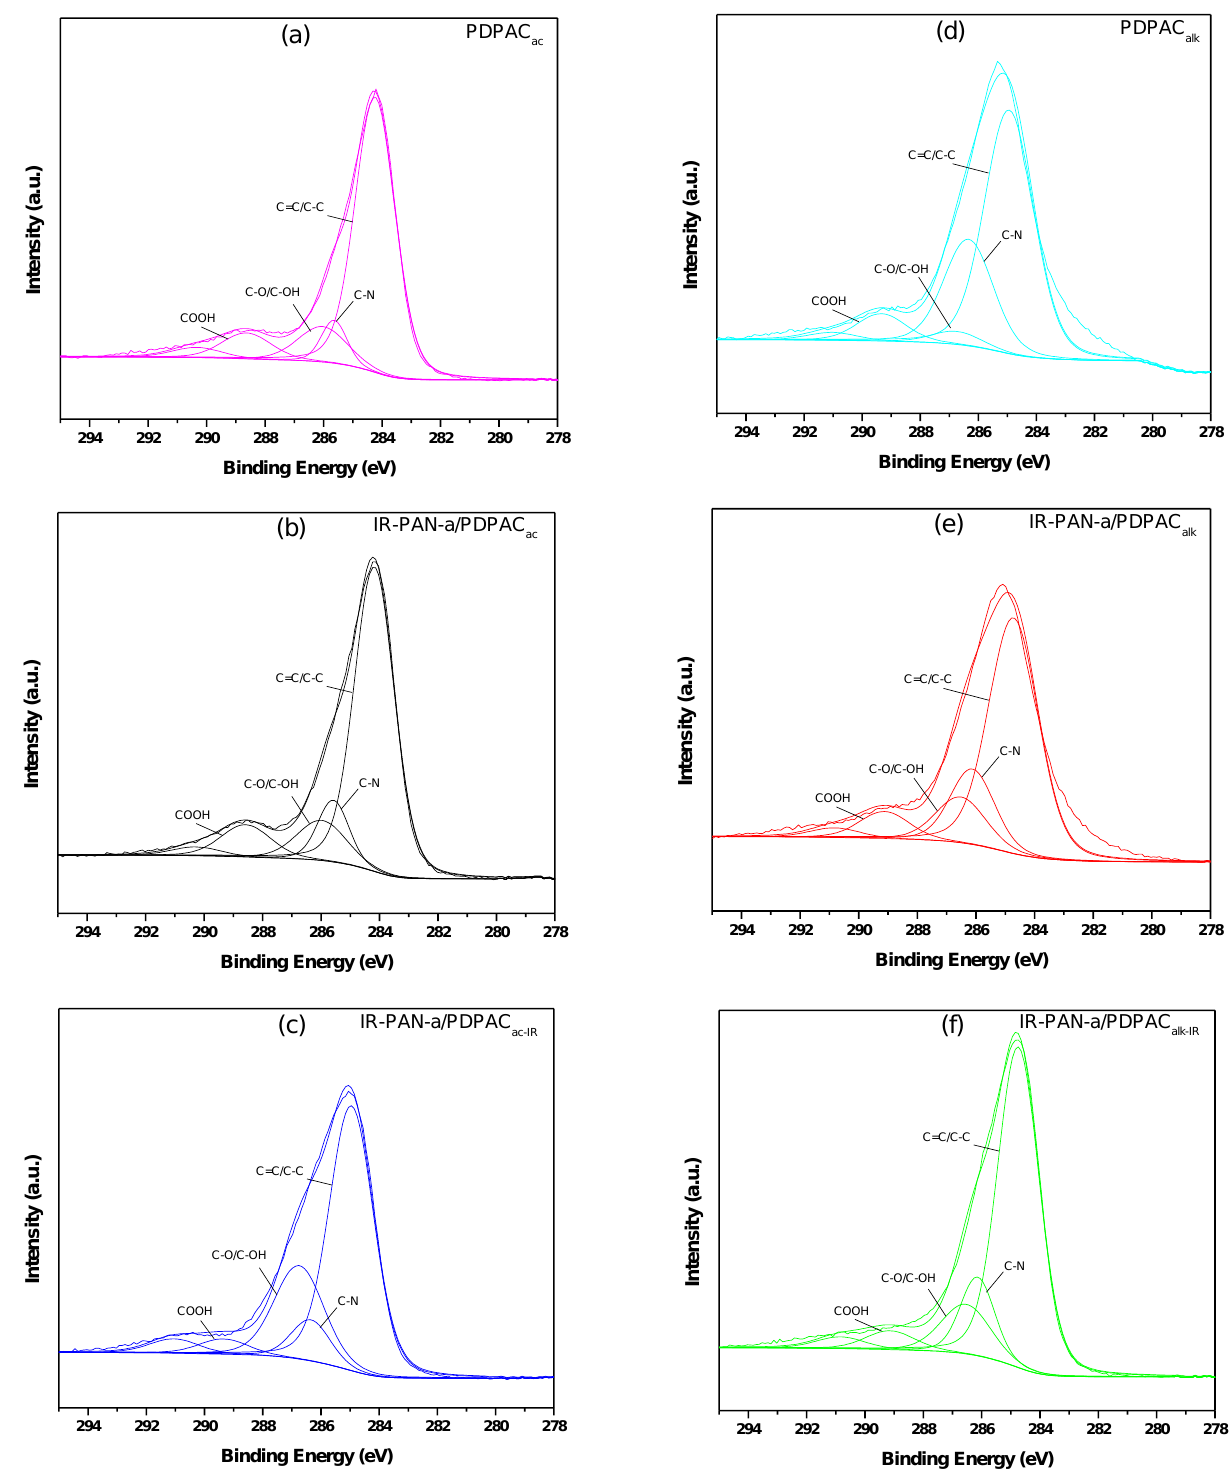
Figure 7. C1s XPS spectra of PDPAC ( a , d ), IR-PAN-a/PDPAC ( b , e ), and IR-PAN-a/PDPAC IR ( c , f )